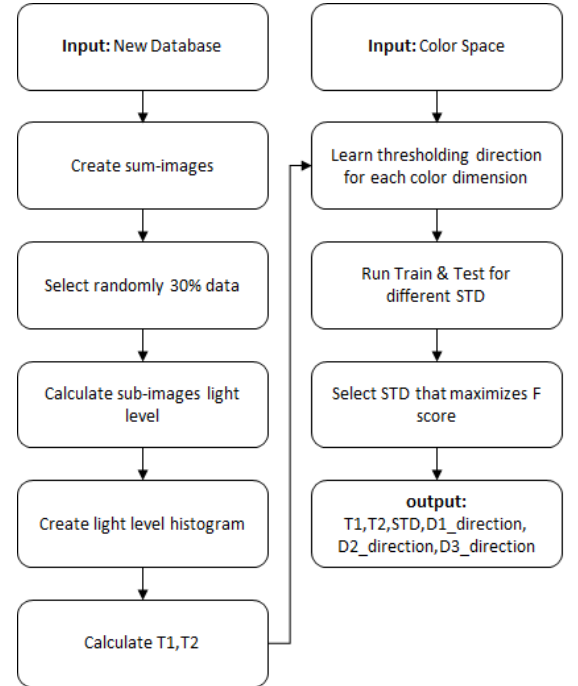
Figure 9. Parameter tuning process.